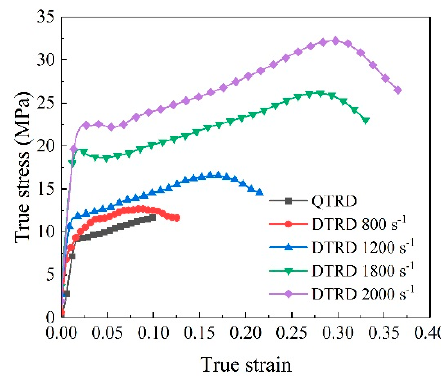
Figure 9. Typical stress–strain curves of beech specimens at different rates in DTRD.